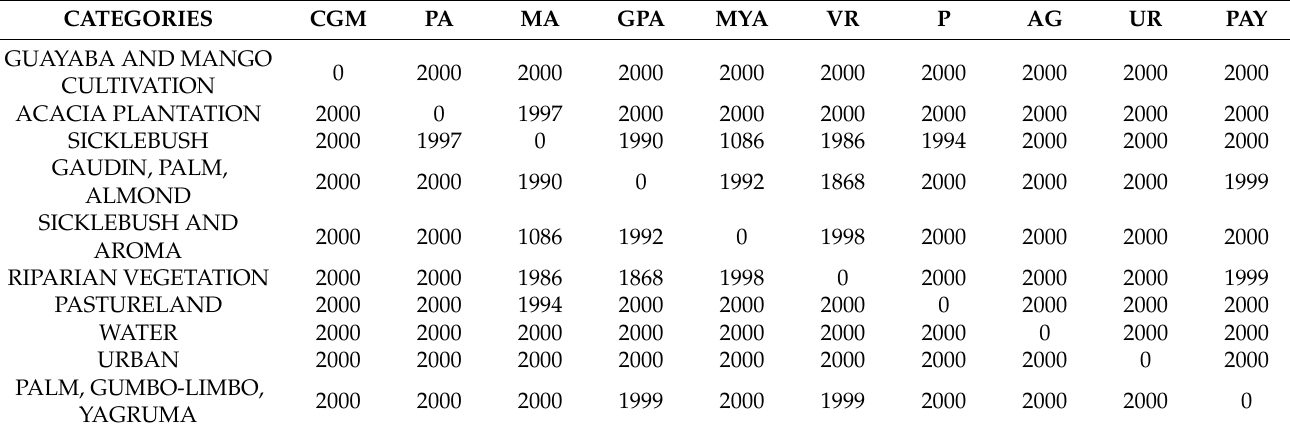
Table 5. Separability matrix derived using the transformed divergence method on a Landsat-8 image of Trinidad-Valle de los Ingenios,